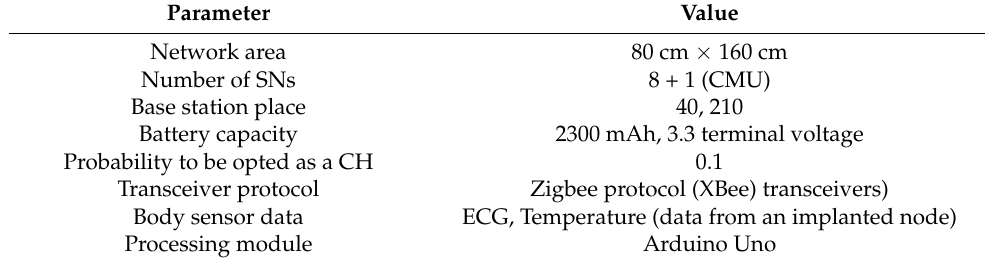
Figure 9. Sample ECG signal.